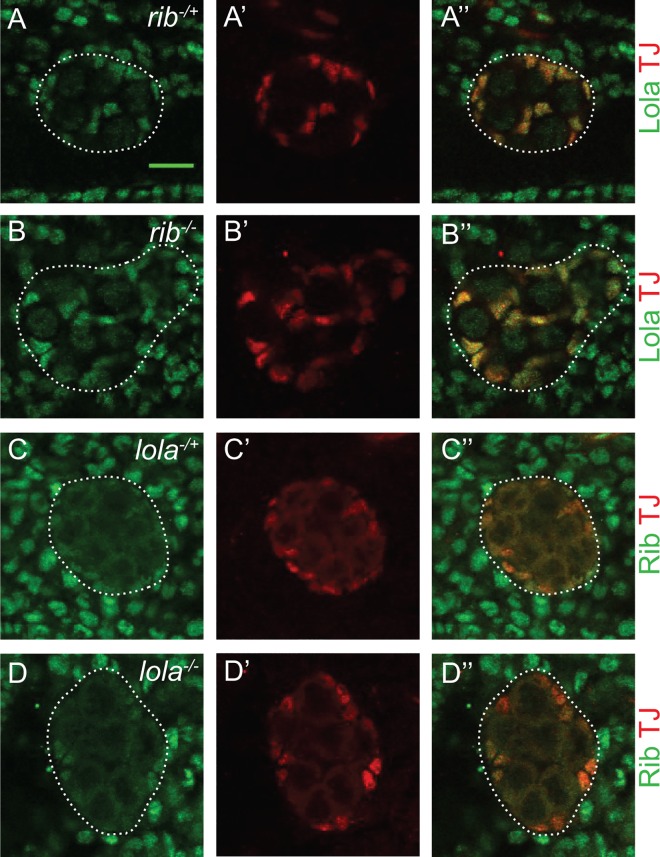
Lola and Rib do not regulate expression of each other.(A-B”) Lola expression in rib heterozygous and homozygous mutant stage 15 gonads, posterior to the right. Anti-Lola (green) and anti-Traffic jam (TJ) marks SGPs (red). (A-A”) rib+/- gonad (rib35.14/+ or rib55.25/+) (n = 16). (B-B”) rib35.14/55.25 gonad (n = 11). (C-D”) Rib expression in lola heterozygous and homozygous mutant stage 15 gonads, posterior to the right. Anti-Rib (green) and anti-TJ marks SGPs (red). (C-C”) lola+/- gonad (lola46.38/+ or lola22.05/+) (n = 11). (D-D”) lola46.38/22.05 gonad (n = 11). The gonad is outlined with a dotted line. Scale bar: 10μm.